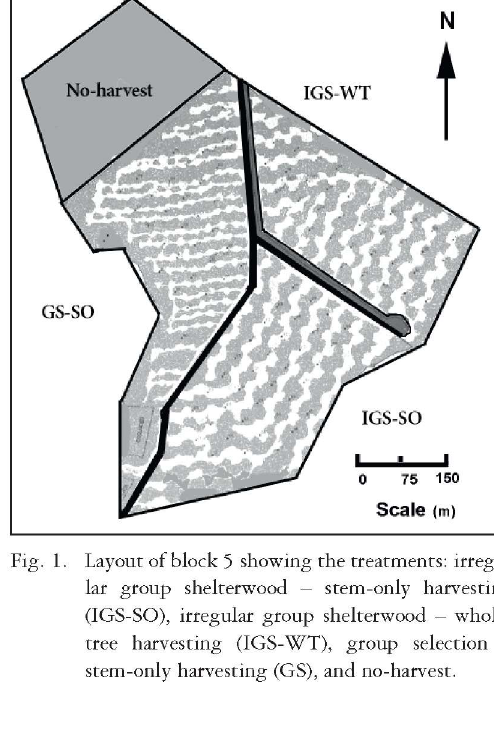
Fig. 1. Layout of block 5 showing the treatments: irregu lar group shelterwood — stem-only harvesting (IGS-SO), irregular group shelterwood — whole- tree harvesting (IGS-WT), group selection — stem-only harvesting (GS), and no-harvest.